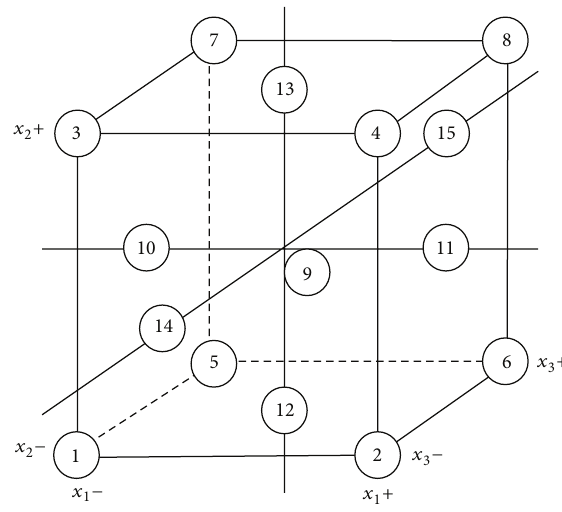
Figure 3: Central composite design for three